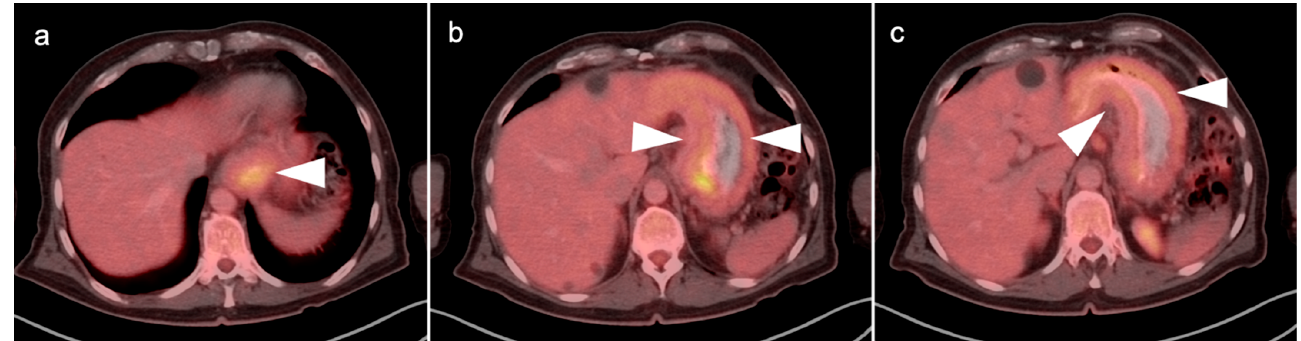
Figure 10. Recurrent gastrinoma. Fused axial FDG PET_CT images of the abdomen show hypertro- phy of the parietal cells in the gastric fundus because of elevated gastrin production. This can mimic gastric cancer as is shown in this case (( a , b ), white arrowheads). Bilateral adrenal metastases are present (( b ), white arrows) There are also dilated fluid-filled loops of bowel due to a hypersecretory state ( c ).